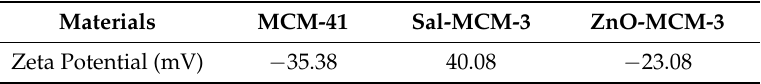
Table 2. Zeta potential of MCM-41, Sal-MCM, and ZnO-MCM.